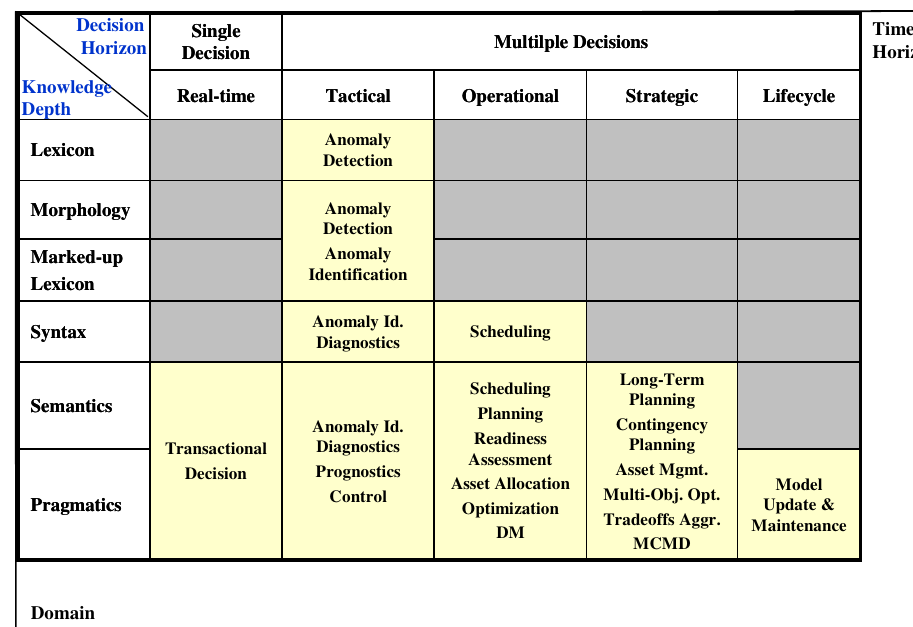
Fig. 4. Framework for SC applications (adapted from reference